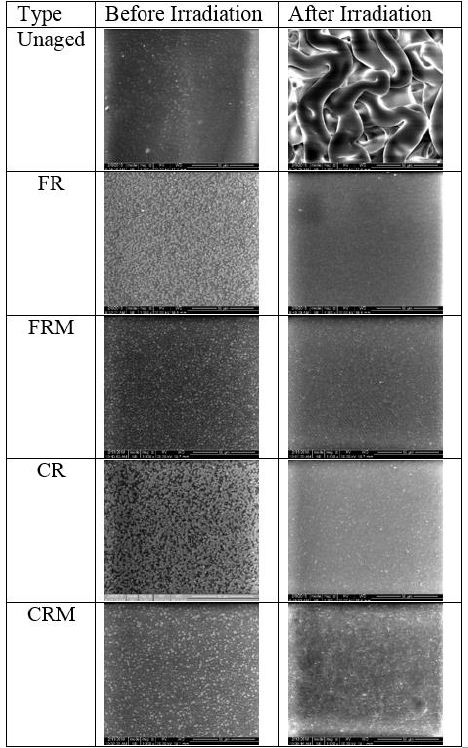
Figure 11. Environmental scanning electron microscopy (ESEM) Images of Samples at 1000 × before Electron Beam Irradiation and After Image Stabilized.